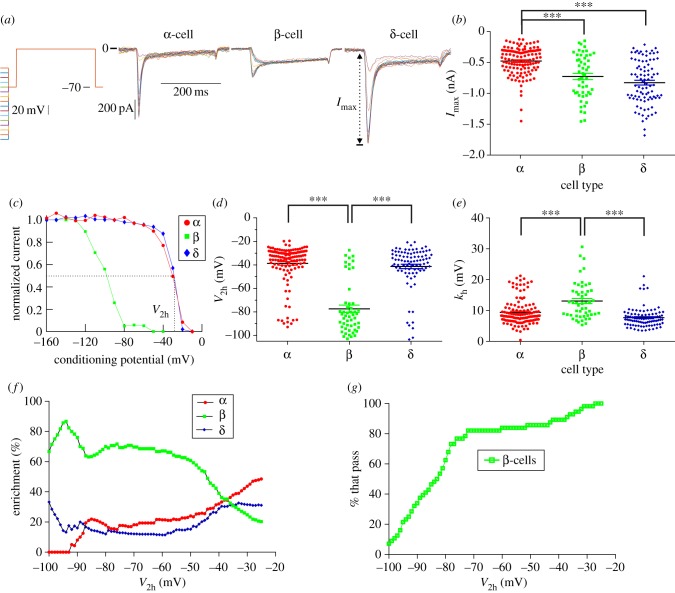
Na+ currents are smallest in α-cells. The maximum Na+ current evoked (a, Imax) by a 200 ms test pulse to 0 mV, following preconditioning pulses, was measured in all cells (b). These data were also used to calculate the normalized peak current as a function of the conditioning potential (c). For each cell, these data were fitted with a sigmoid to quantify the half-inactivation V2h (d) and the slope factor kh (e). The number of cells with V2h < a fixed cut-off (−25 to −100 mV) was counted. The percentage of these cells that are β-cells (enrichment, f) and the percentage of all β-cells that pass this criterion (% that pass, g) were then calculated. One-way ANOVA with Tukey's post hoc test (***p < 0.001). N = 141 α-cells, N = 56 β-cells and N = 91 δ-cells. (Online version in colour.)